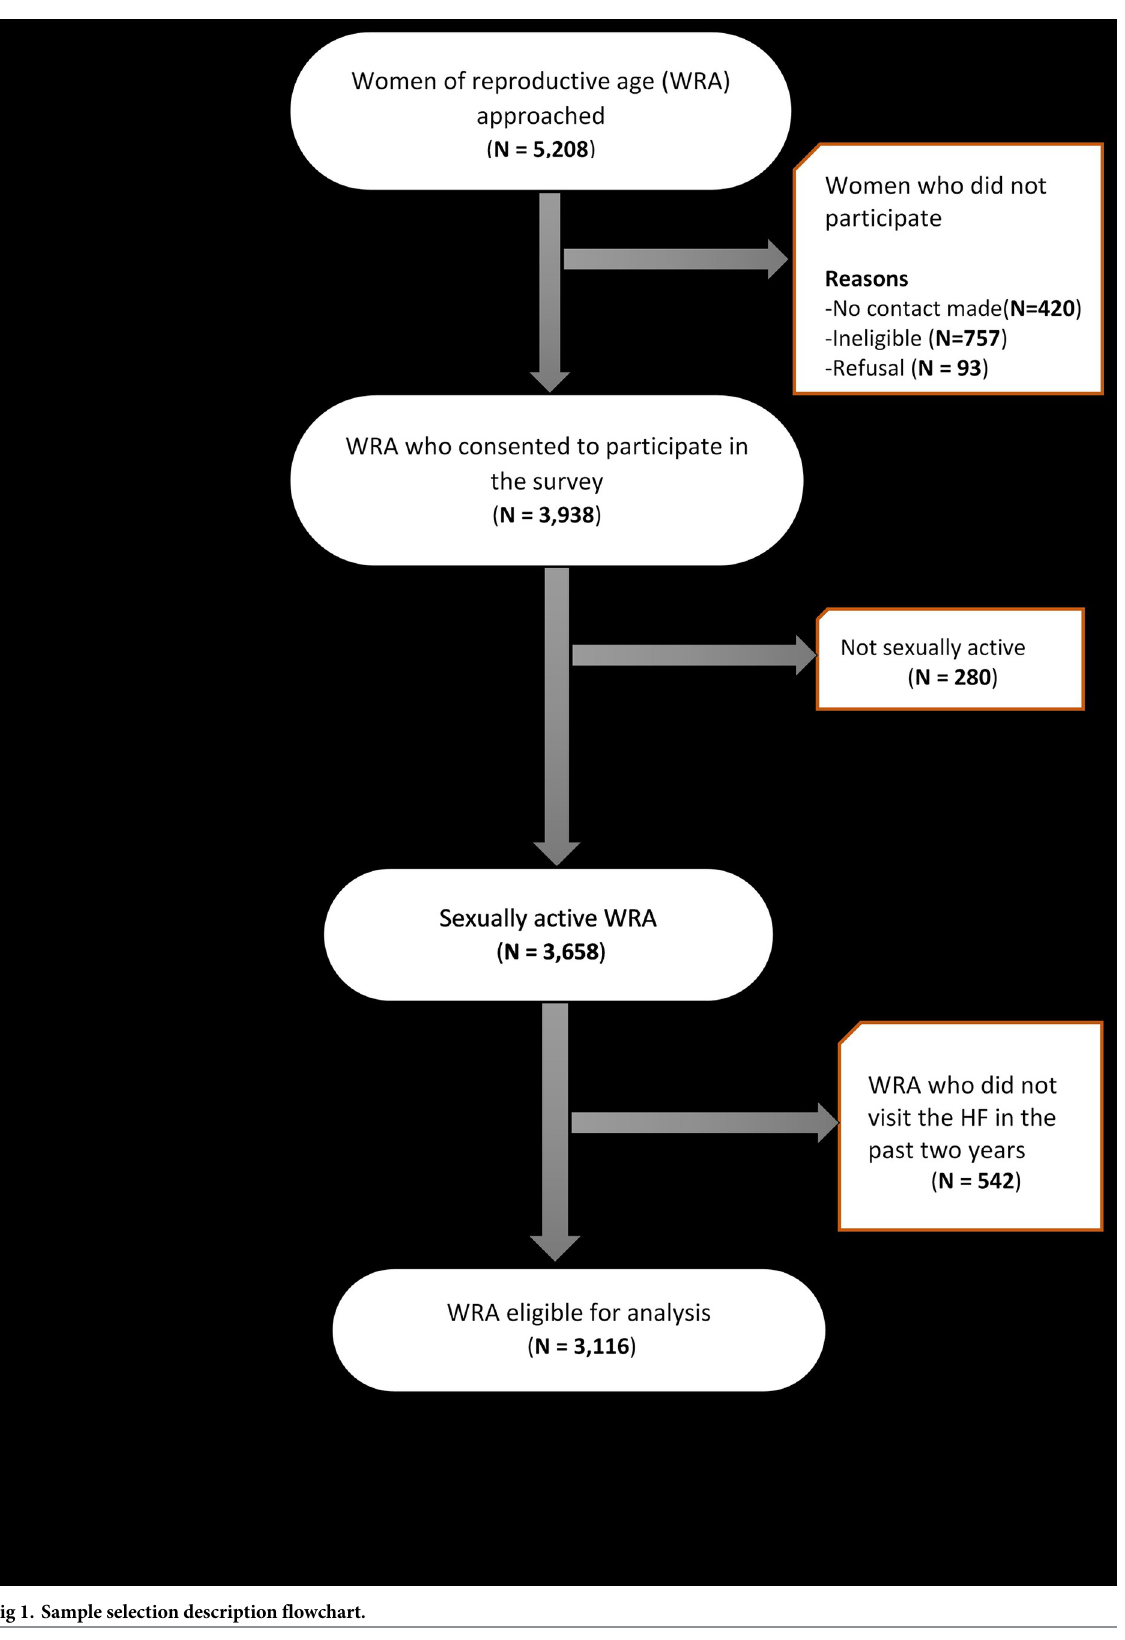
Fig 1. Sample selection description